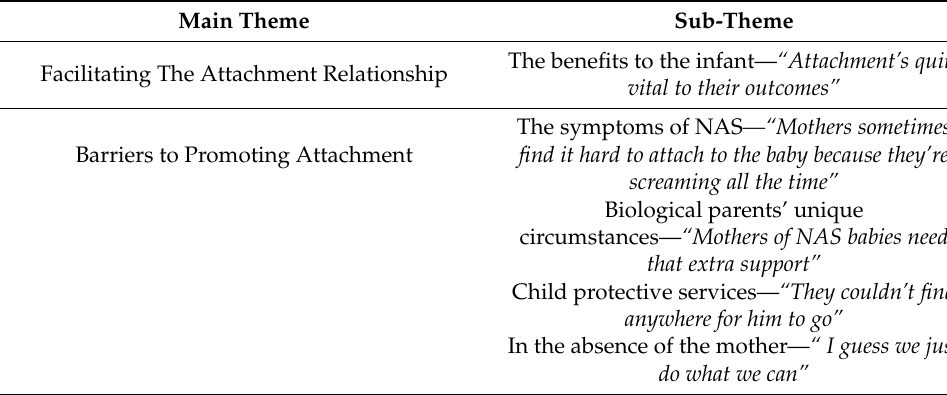
Table 1. Summary of main themes and sub-themes from interview